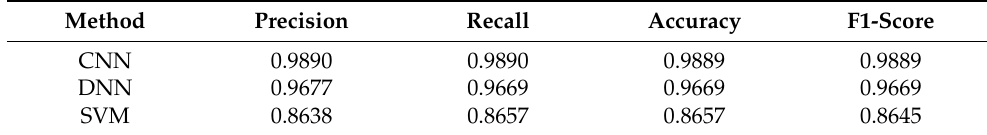
Table 1. Performance Metrics of Considered